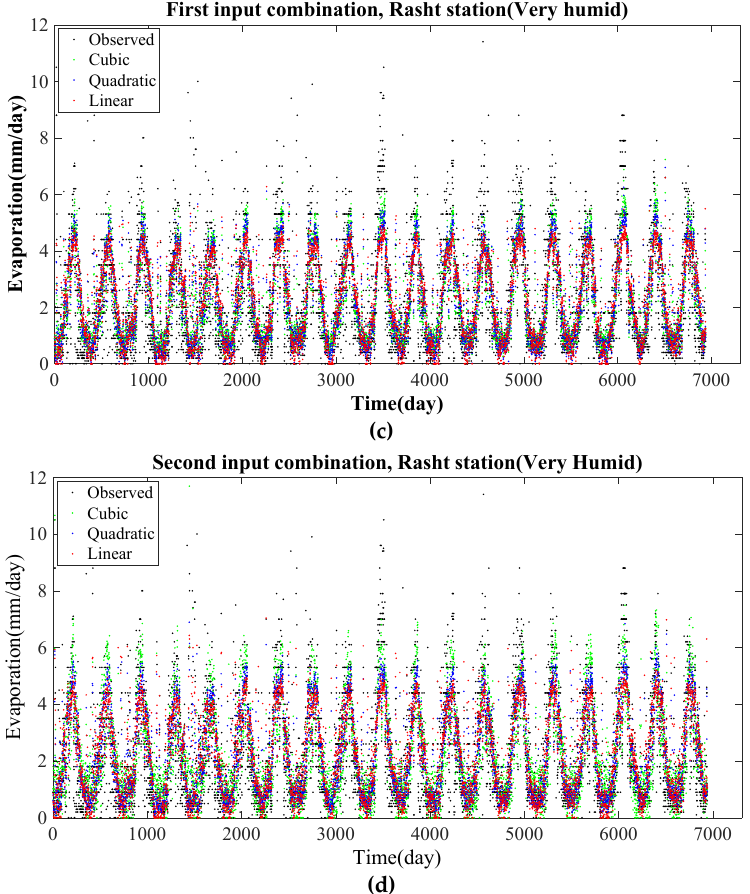
Figure 4. Time series of observed and simulated pan evaporation using linear, quadratic, and cubic experimental relationships (shown in red, blue, and green, respectively) and two input combinations (2000–2020, Table 1). ( a ) Semnan station (dry, two-parameter input combination), ( b ) Semnan station (dry, four-parameter input combination), ( c ) Rasht station (very humid, two-parameter input combination), and ( d ) Rasht station (very humid, four-parameter input combination). Observed evaporation (2000–2020) is shown in black.